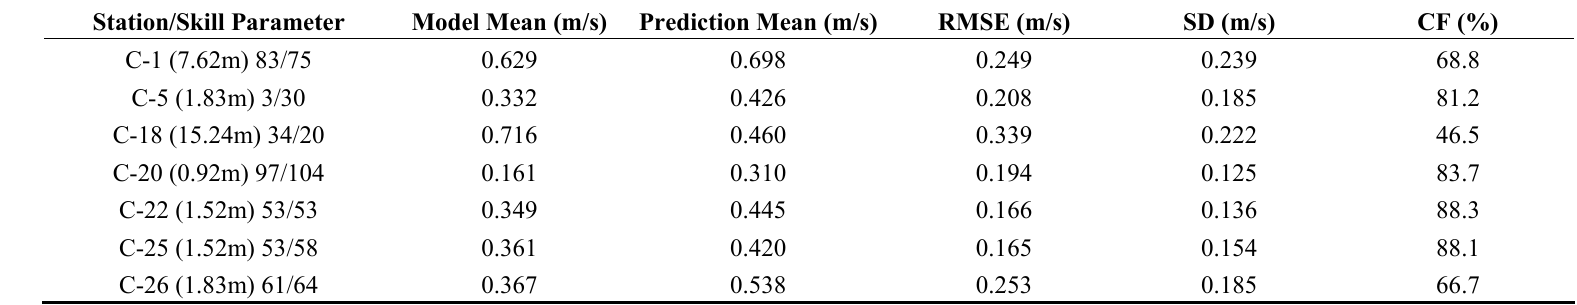
Table 8. Nineteen-month Tidal Simulation Principal Component Direction Current Strength Skill Assessment Results. Note measurement depth given in parenthesis followed by observed/model principal current direction. RMSE is root mean square error, SD is standard deviation of the error; e.g., model minus observation, and CF is central frequency of the errors with respect to a reference level of 0.26